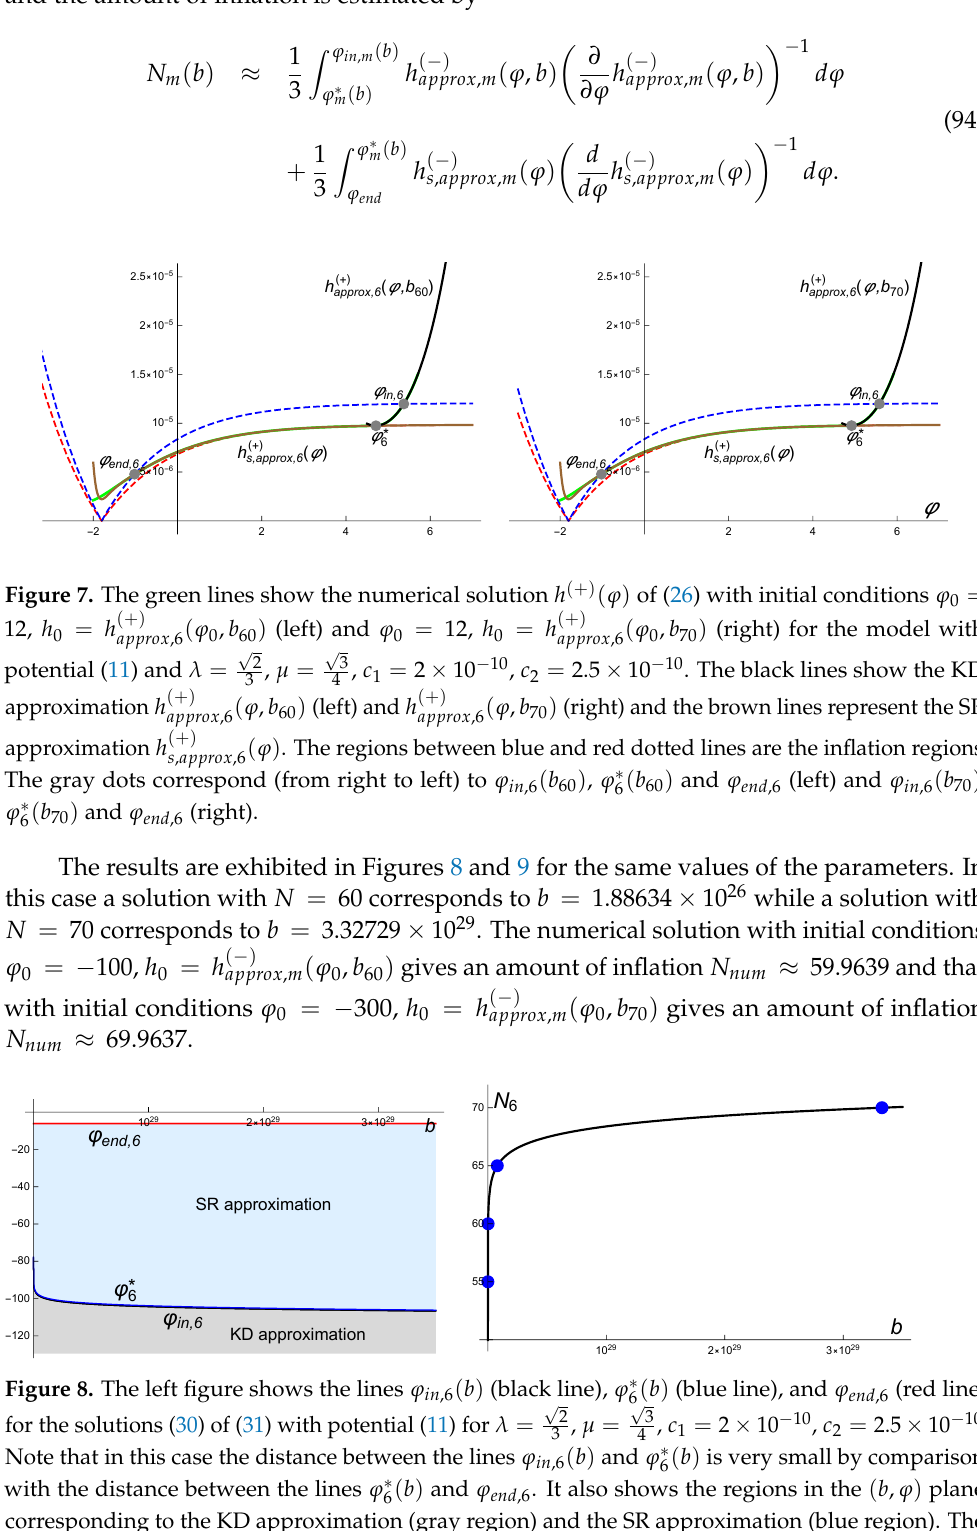
Figure 8. The left figure shows the lines ϕ in ,6 ( b ) (black line), ϕ ∗ for the solutions (30) of (31) with potential (11) for λ = Note that in this case the distance between the lines ϕ in ,6 ( b ) and ϕ ∗ with the distance between the lines ϕ ∗ corresponding to the KD approximation (gray region) and the SR approximation (blue region). The right figure shows the amount of the inflation N 6 ( b ) . The blue dots indicate the values N = 55, 60, 65, and